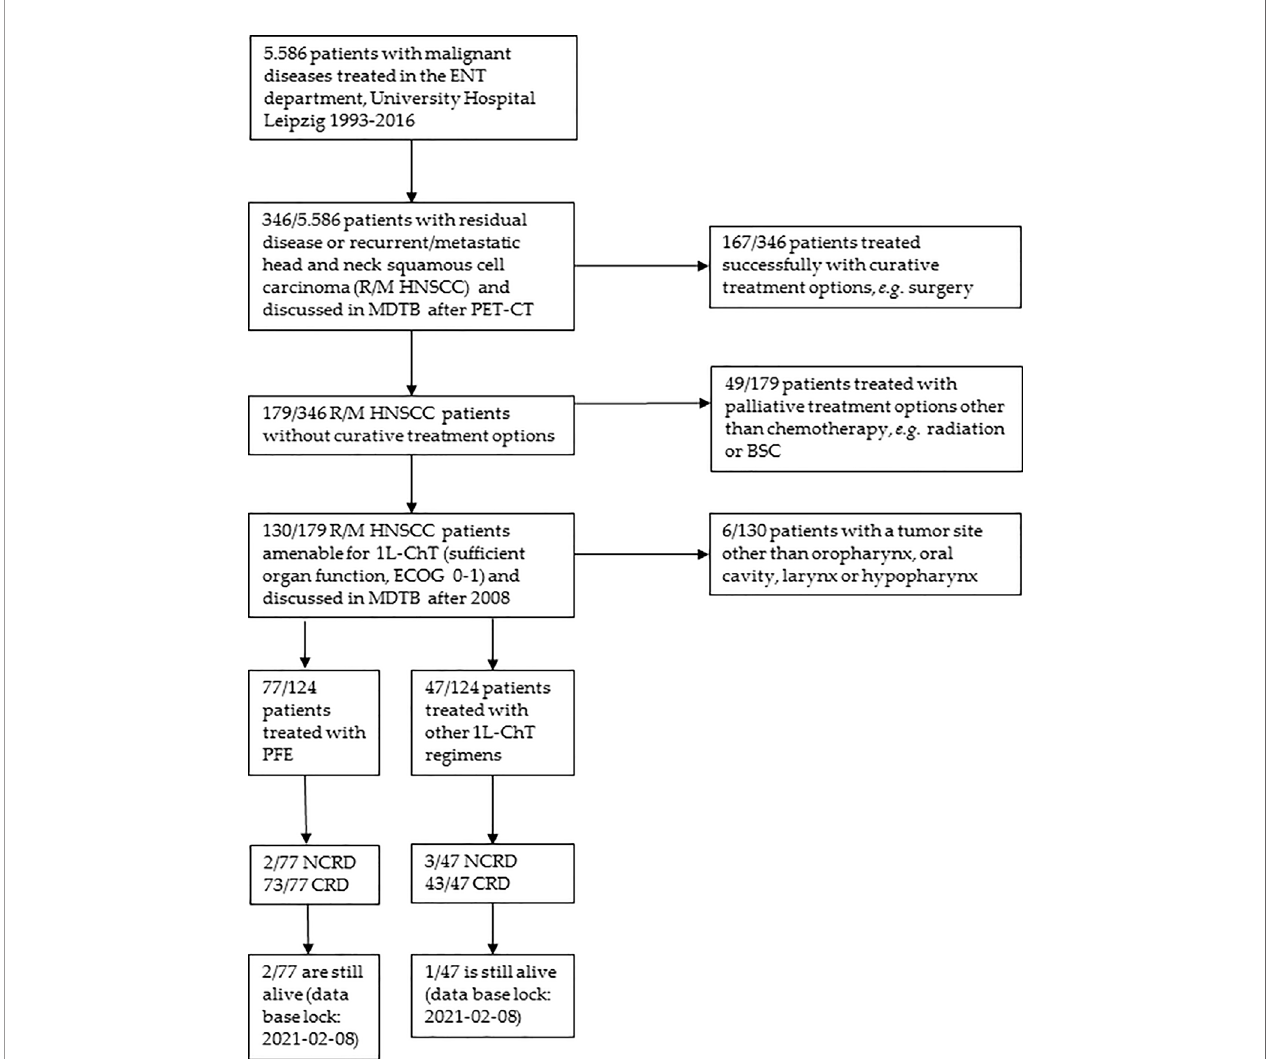
FIGURE 1 | CONSORT diagram showing the selection criteria of recurrent/metastatic head and neck squamous cell carcinoma (R/M HNSCC) patients of the two cohorts compared. ECOG, Eastern Cooperative Oncology Group performance score; BSC, Best Supportive Care; MDTB, multi-disciplinary tumor board; NCRD, non cancer-related death; CRD, cancer-related